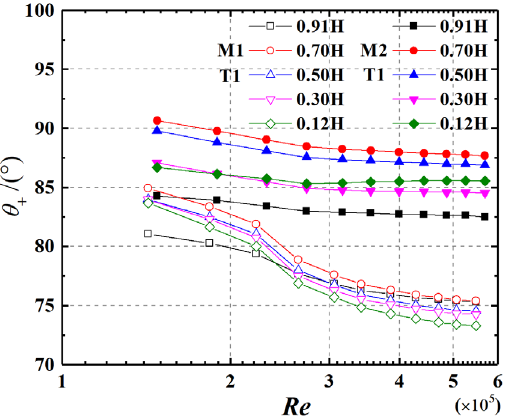
Figure 9. The variation of positive pressure range with Re at different height of